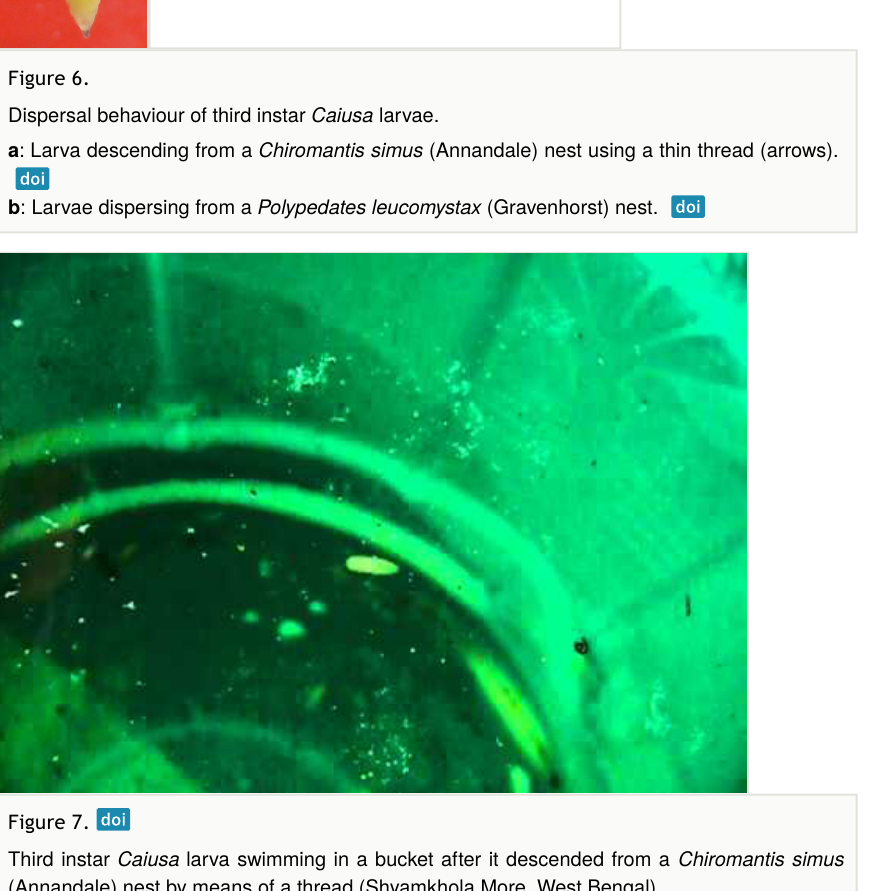
Third instar Caiusa larva swimming in a bucket after it descended from a Chiromantis simus (Annandale) nest by means of a thread (Shyamkhola More, West